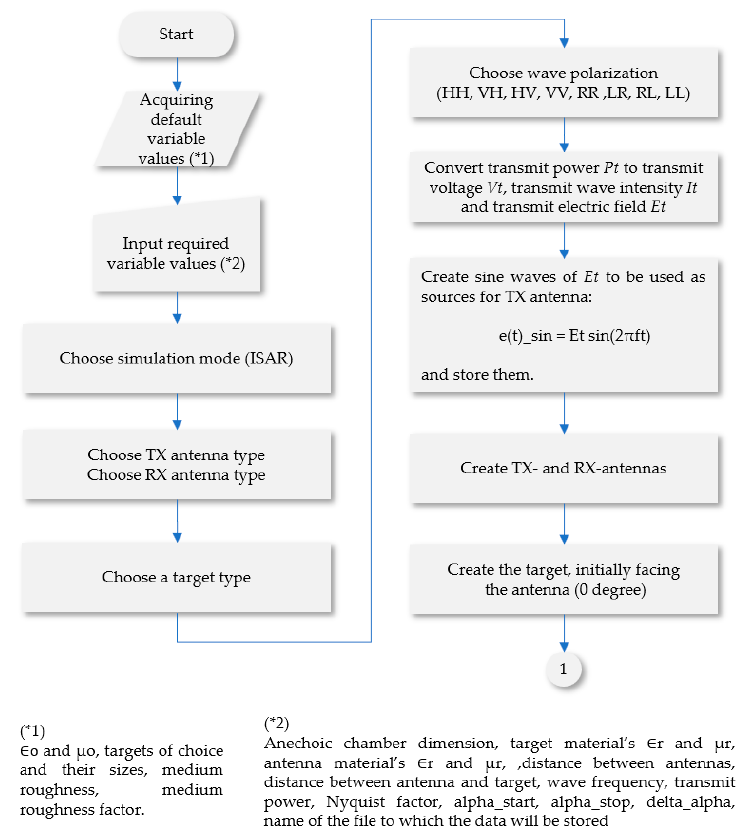
Figure 3. Critical design review of Anechoic Chamber Simulation Tool Version 1 (AST_V1) presented in a flow chart (part 1).